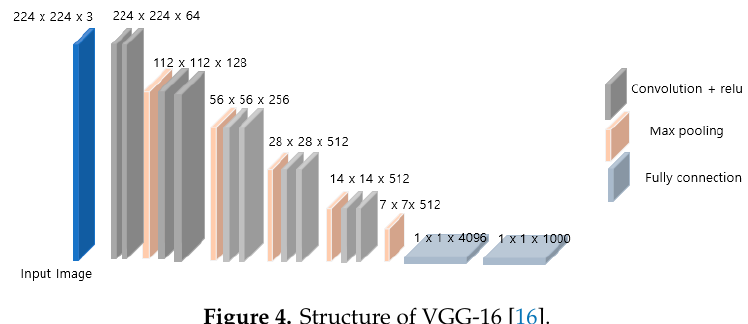
Figure 4. Structure of VGG-16 [16].